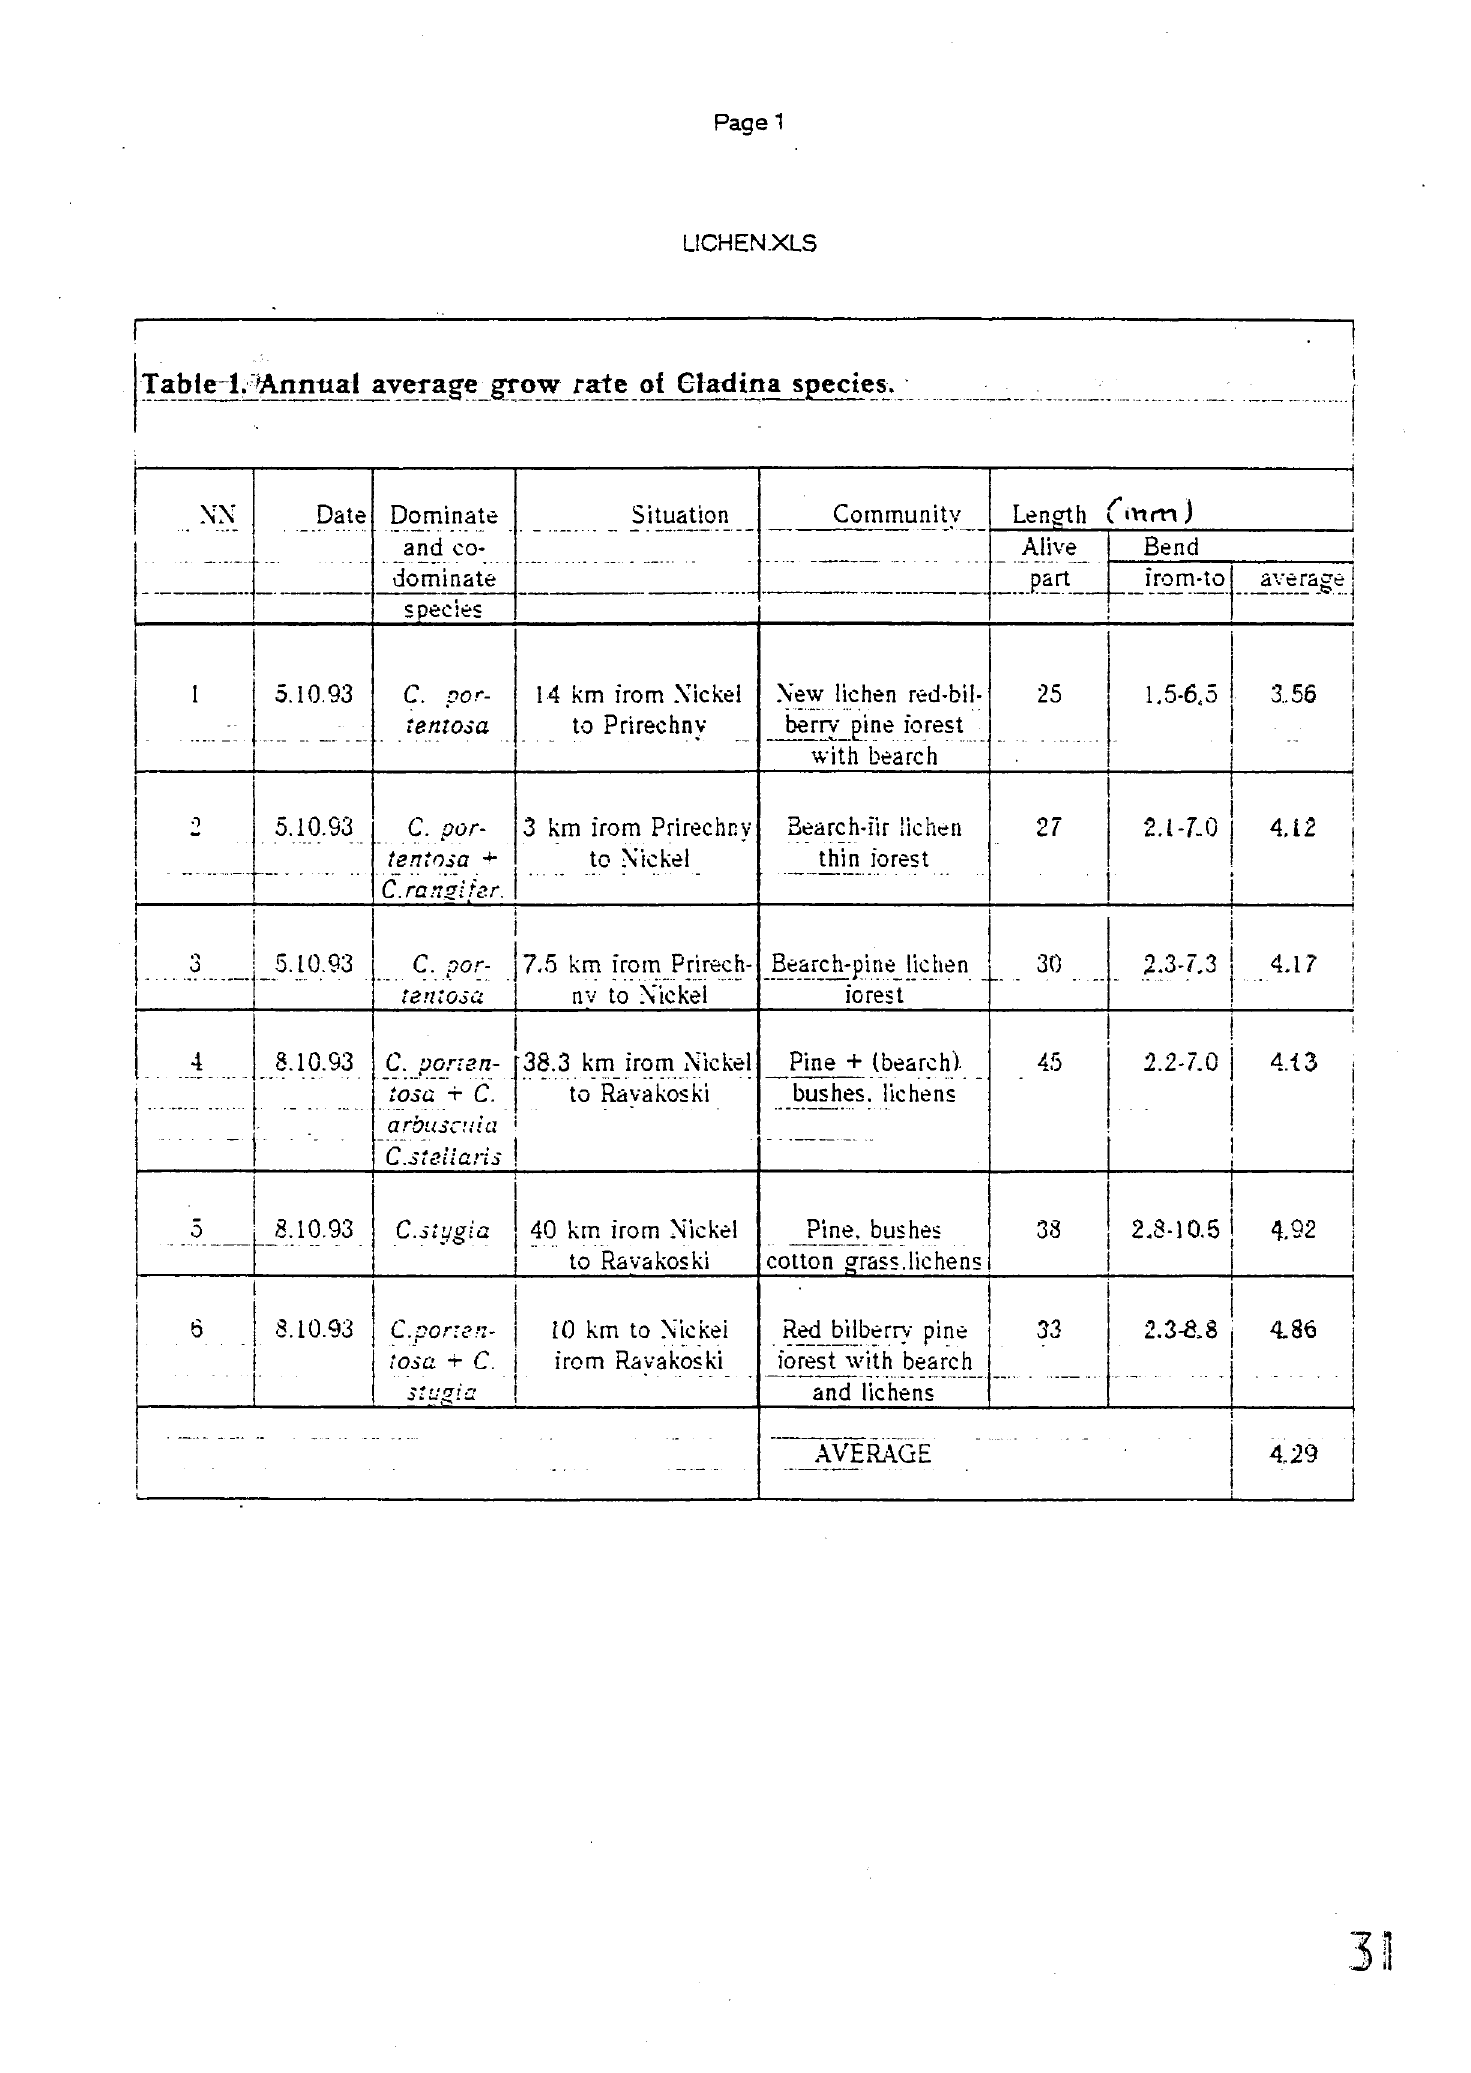
Tab le i. ^Annual average grow rate oi Gtadina